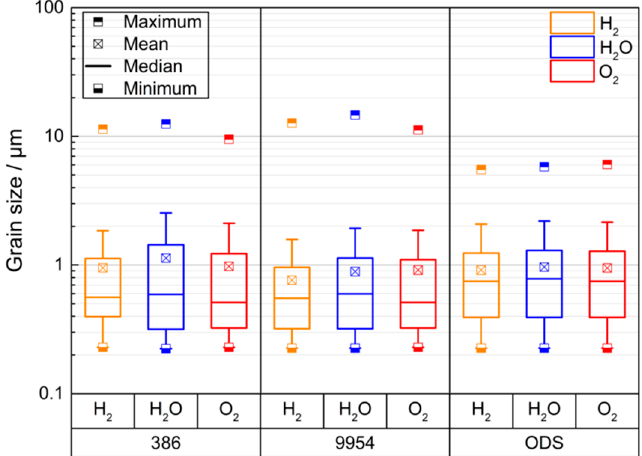
Figure 3. Distribution of the grain sizes of Amdry 386, Amdry 9954 and Amdry 9954 + ODS after a heat treatment at 1100 °C for 72 h in argon with the addition of 4% H 2 + 2% H 2 O, 2% H 2 O and 20% O 2 .